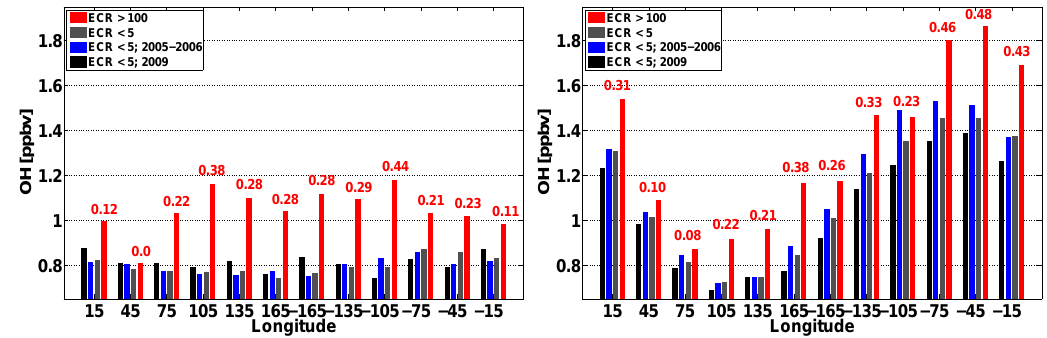
Fig. 7. Longitudinal variations of OH medians at geomagnetic latitudes 55–72 ◦ N (left panel) and 55–72 ◦ S (right panel) and altitudes between 70 and 78km for 4 selected cases (see description in the text). Numbers indicate the absolute (ppbv, red) difference between OH during high EEP (case I) and the OH during the low geomagnetic activity (case